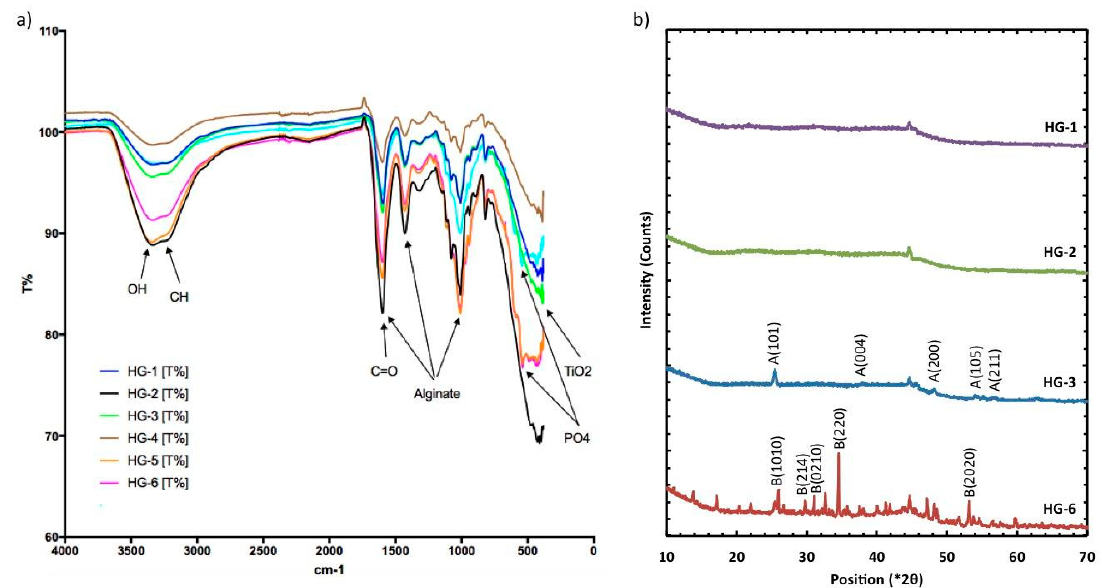
Figure 4. ( a ) FT-IR Identification of functional groups and major components of the dried composite hydrogels. Refer to Table 1 for the hydrogel compositions. ( b ) XRD plots of dry hydrogel where TiO 2 (A) is identified as the crystal nanoparticles and calcium phosphate (B) as the TCP component.